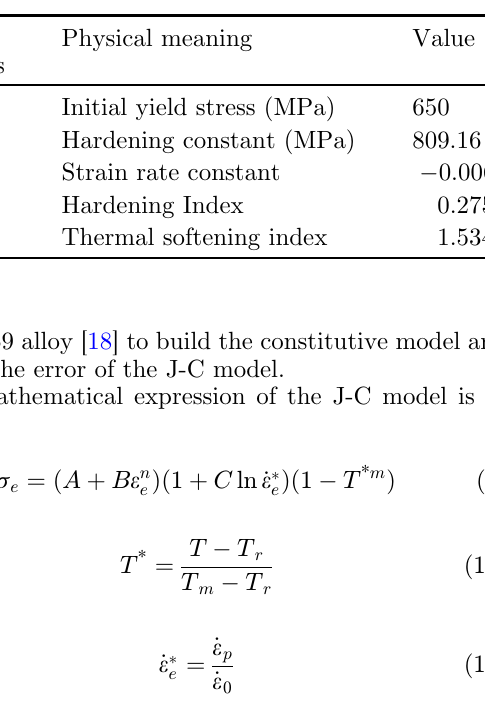
Table 3. GH4169 alloy Johnson – Cook (J-C) model parameters.